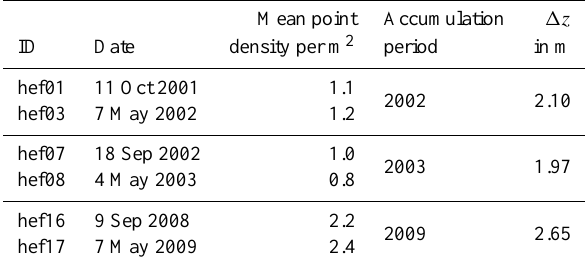
Table 1. ID-number, aquisition dates and point densities of the used ALS data. Year of accumulation season, which is used later on, and the mean surface elevation change 1z between the respective DEMs of the whole catchment are